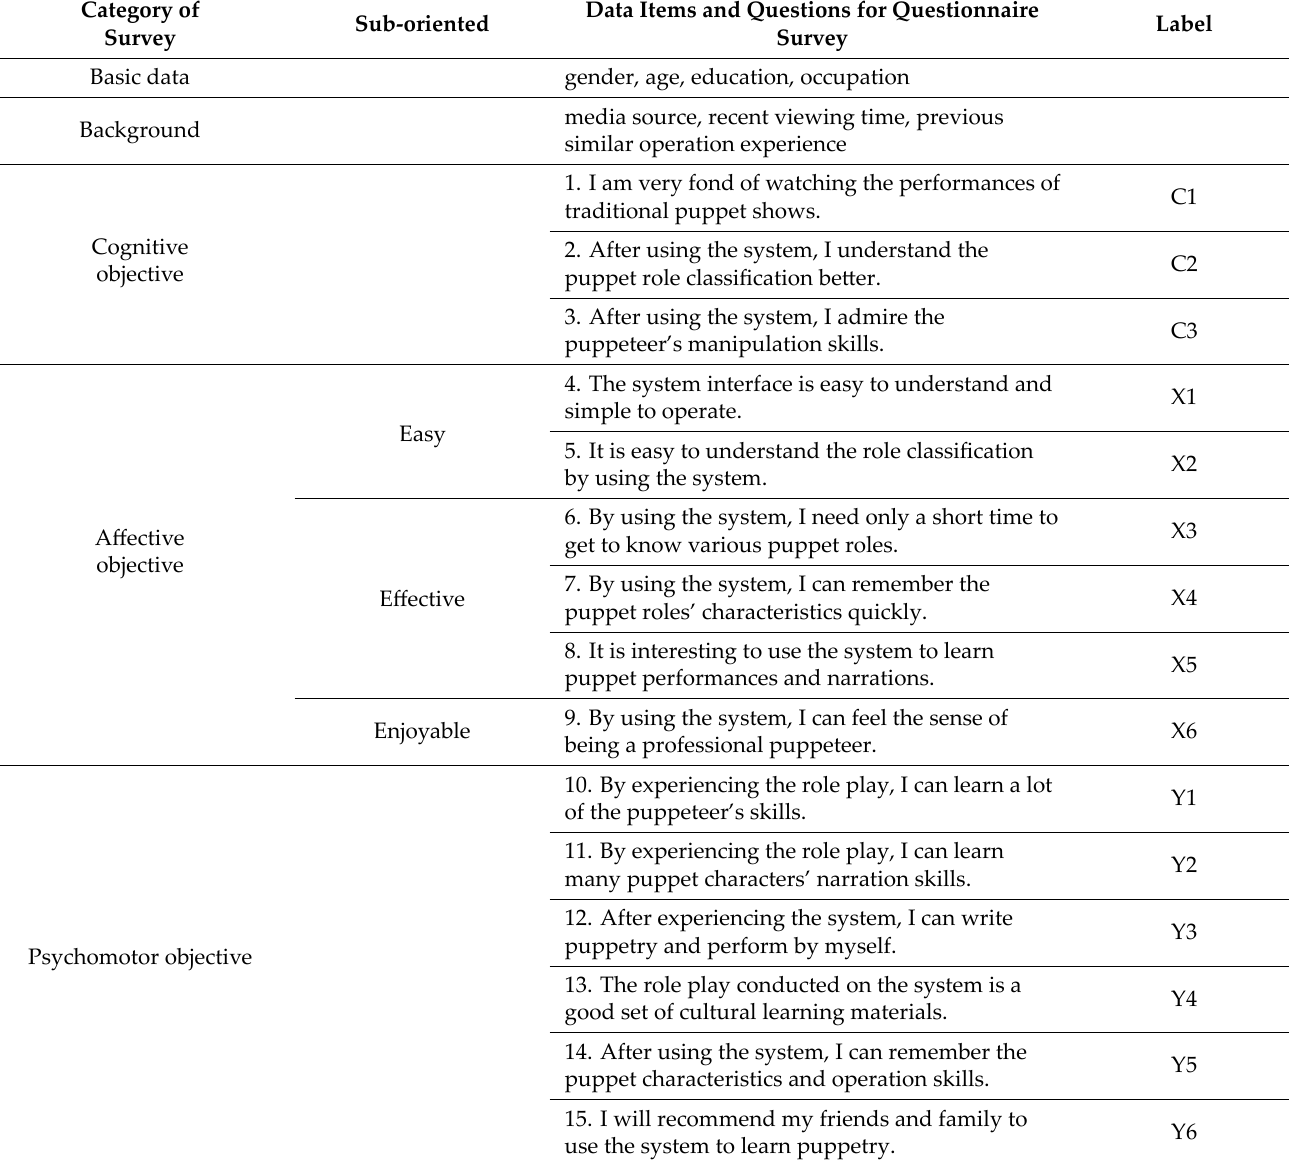
Table 5. Question categorization of the questionnaire survey questions and participants’ data. Category of Data Items and Questions for Questionnaire Sub‑oriented Survey